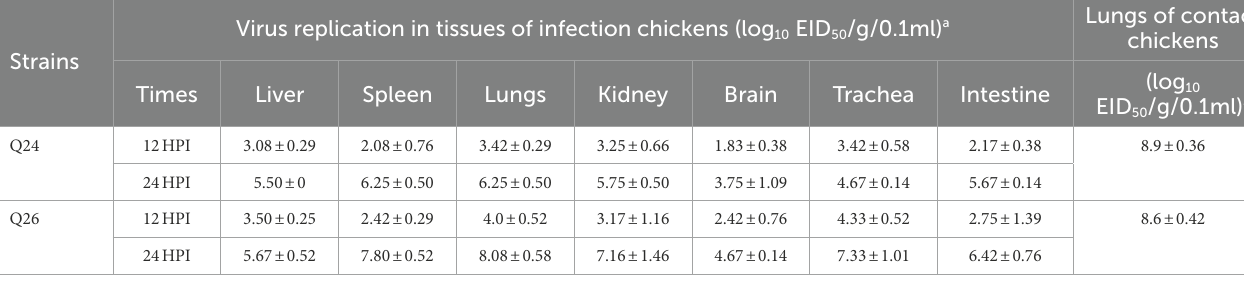
TABLE 4 Replication in the chickens of the H7N9 viruses after inoculated intranasally a .